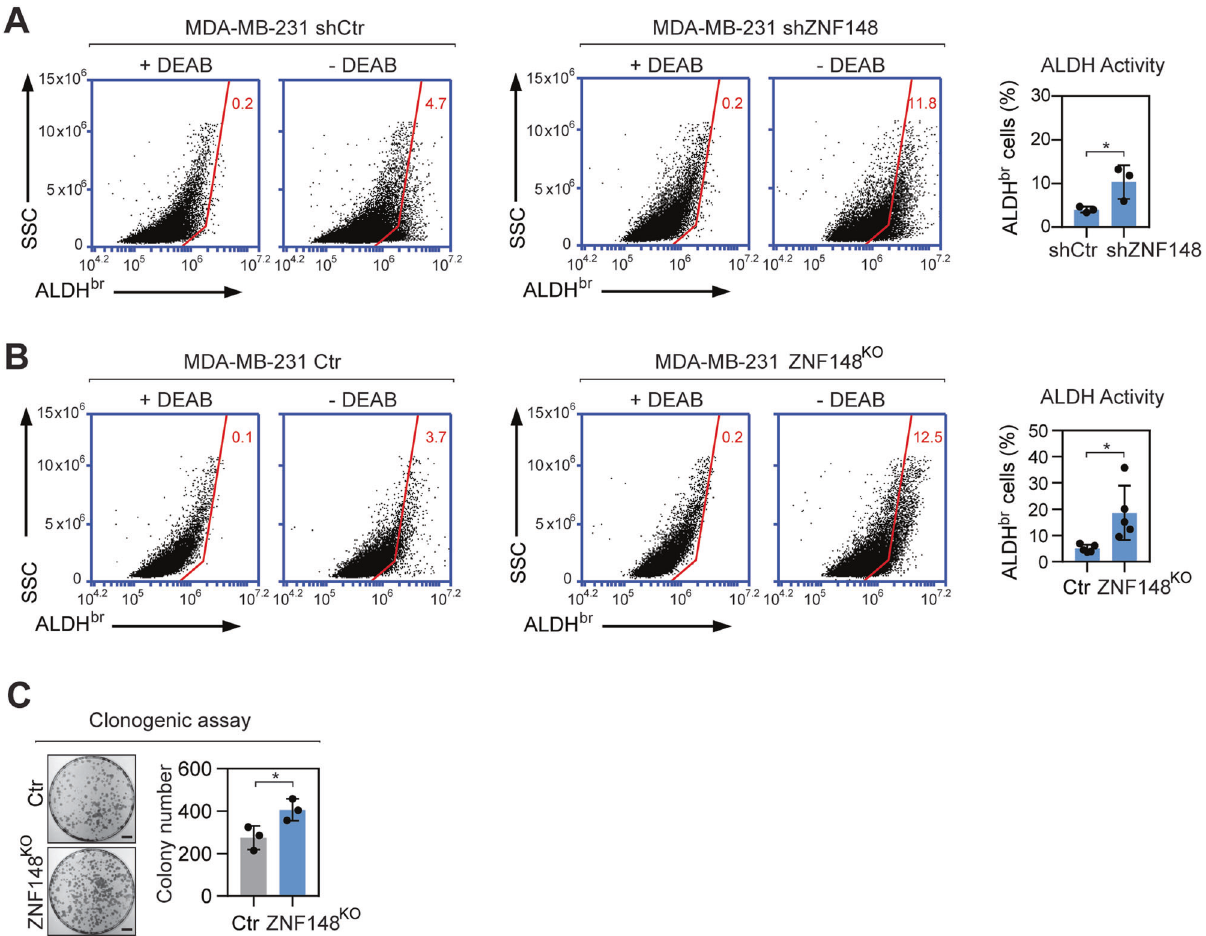
Fig. 6 Loss of ZNF148 increases breast cancer cell stemness. A Representative fl ow cytometry plots and a bar graph, showing the percentage of viable Aldehyde dehydrogenase bright (ALDH br ) shCtr and shZNF148 MDA-MB-231 cells in the presence ( + ) or absence ( − ) of diethylaminobenzaldehyde (DEAB) ( n = 3). B As in “ A ” showing the percentage of ALDH br cells in MDA-MB-231 Control and MDA-MB-231- ZNF148 KO cells ( n = 5). C Representative image of clonogenic assay of cells in “ B ” stained with crystal violet ( n = 3). Scale bar = 1 cm. Error bars represent mean ± SD. Student ’ s t-test, * P < 0.05. SSC side scatter; ALDH br Aldehyde dehydrogenase bright; Ctr Control; KO knockout; DEAB